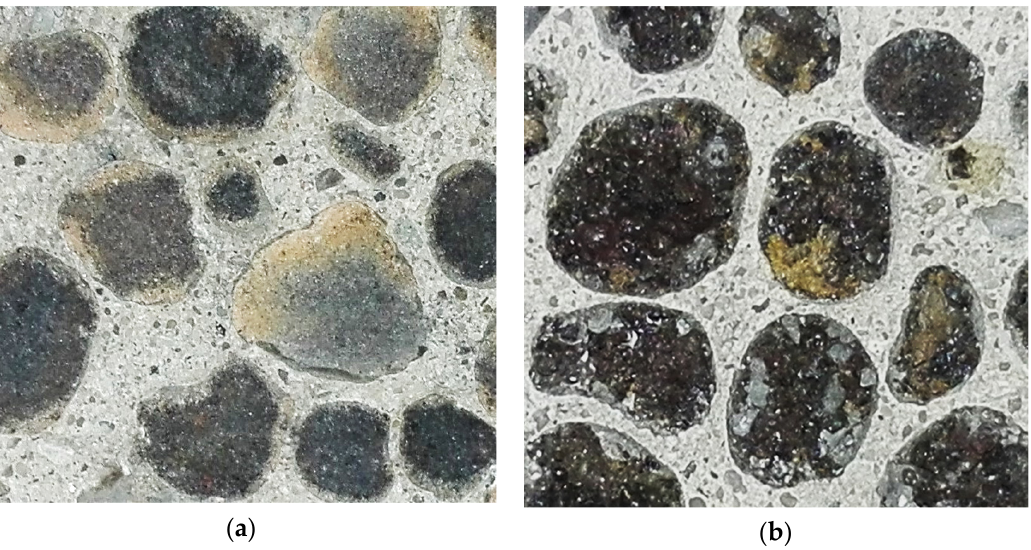
Figure 14. Bond between cement matrix and impregnated lightweight aggregates (4/8 mm) in concretes at fracture under compressive load: ( a ) sintered fly ash and ( b ) expanded clay.